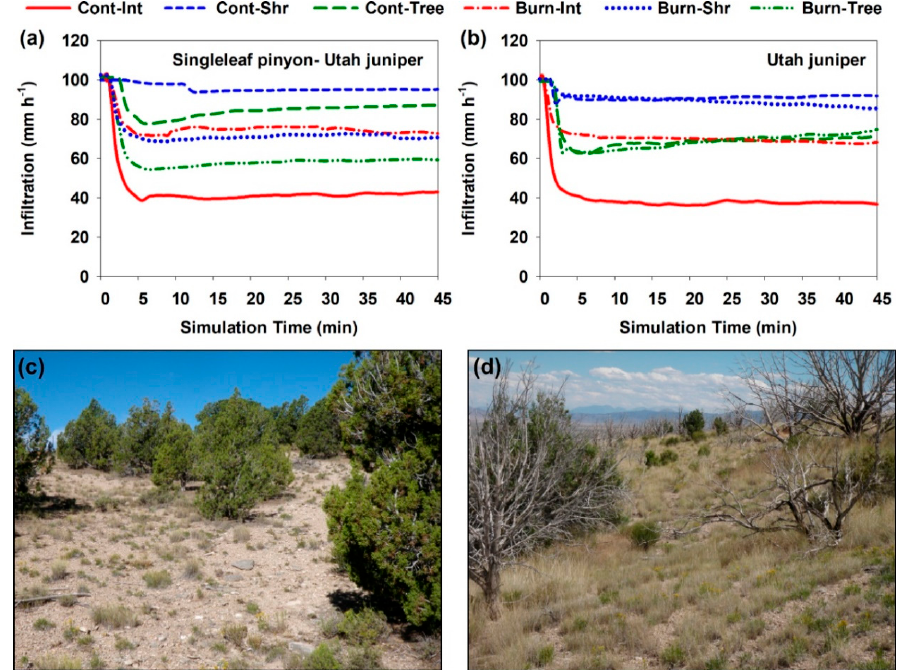
Figure 4. Infiltration ( a , b ) from rainfall simulation experiments (102 mm h − 1 , 45 min, 0.5 m 2 plots) in untreated interspaces between shrubs and trees (Cont-Int), untreated shrub (Cont-Shr) and tree (Cont-Tree) canopy areas, burned interspaces (Burn-Int), and burned shrub (Burn-Shr) and tree (Burn-Tree) canopy areas in a singleleaf pinyon ( P. monophylla Torr. & Frém.)-Utah juniper ( J. osteosperma [Torr.] Little) woodland ( a ) and a Utah juniper woodland ( b ) 9 year after prescribed fire. Photographs at bottom of figure show the untreated Utah juniper woodland with extensive intercanopy area comprised primarily of bare interspace and limited shrub cover ( c ) and the same site 9-year post-fire with well-distributed intercanopy herbaceous cover ( d ). Data from Williams et al. [51]. Figure modified from Miller et al.